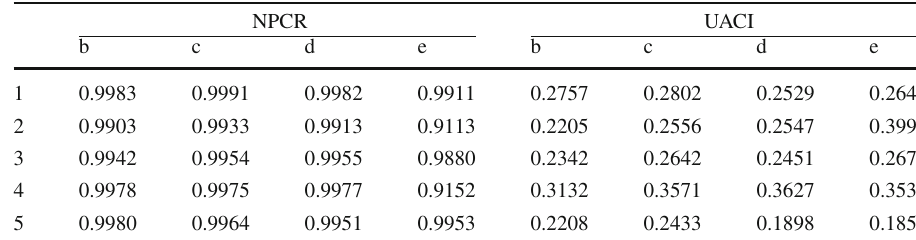
Table 3 NPCR and UACI experimental results